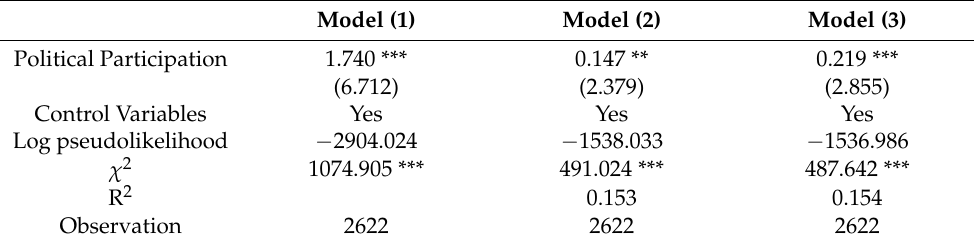
Table 3. Robustness